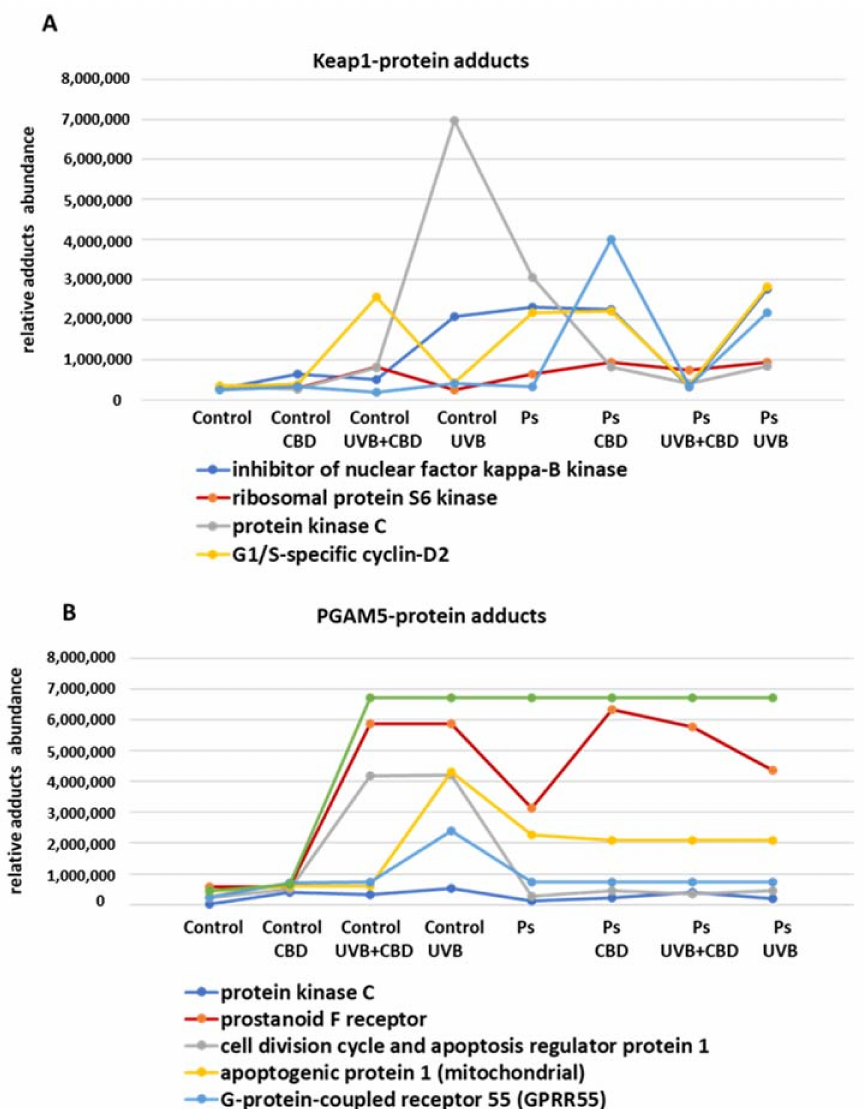
Figure 5. ( A ) Keap1–protein adducts in keratinocyte cell lines from healthy subjects (Control; n = 5) and psoriatic patients (Ps; n = 5) after irradiation with UVB (60 mJ/cm 2 ) and incubation with CBD (4 µ M). The point graph shows preliminary results of relative protein abundance of proteins making Keap-1 complexes in keratinocytes from healthy subjects and psoriatic patients (Ps) after UVB exposure and incubation with CBD. ( B ) PGAM5–protein adducts in keratinocyte cell lines from healthy subjects (Control; n = 5) and psoriatic patients (Ps; n = 5) after irradiation with UVB (60 mJ/cm 2 ) and incubation with CBD (4 µ M). The point graph shows preliminary results of relative protein abundance of proteins making PGAM5 complexes in keratinocytes from healthy subjects and psoriatic patients (Ps) after UVB exposure and incubation with